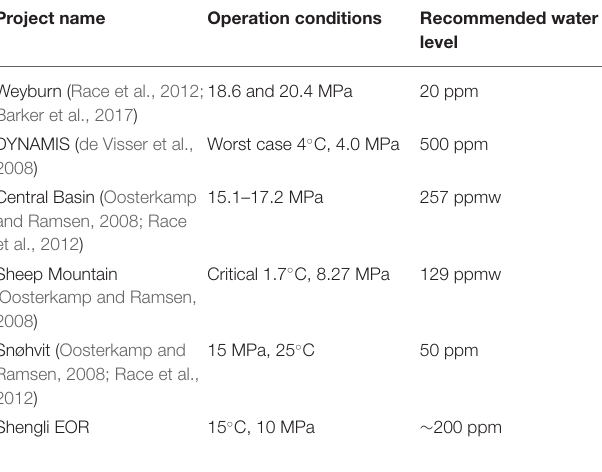
TABLE 1 | Practical recommendation of water concentrations in CO 2